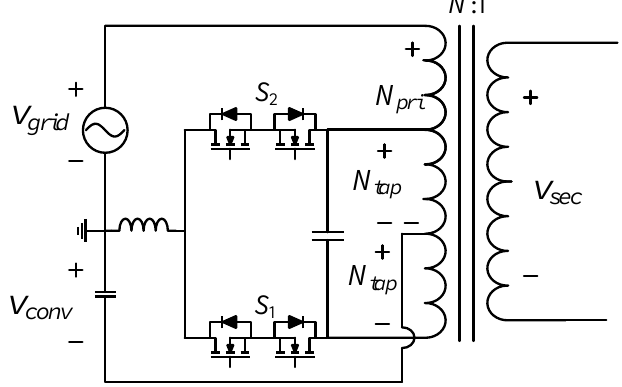
Figure 2. Active hybrid solid state transformer.